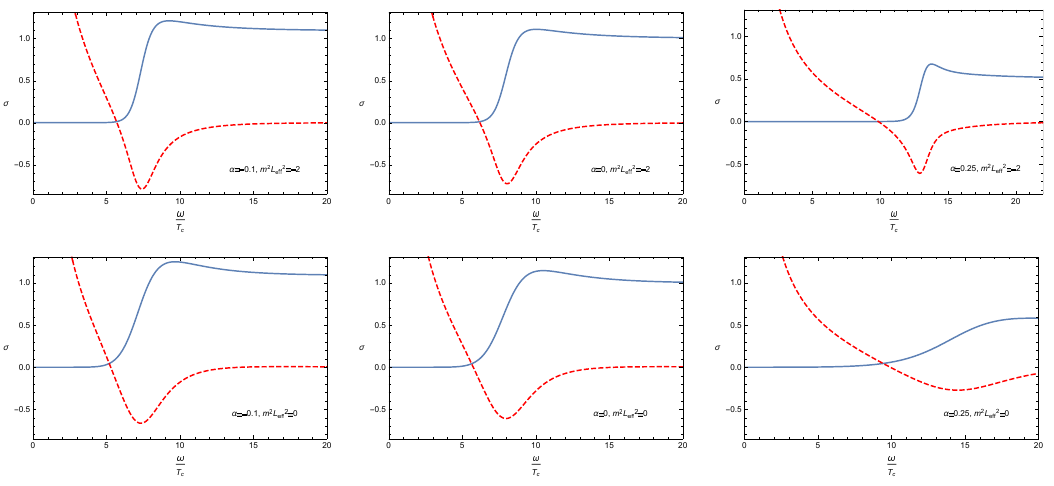
= − 2 and 0 . In each panel, the eff